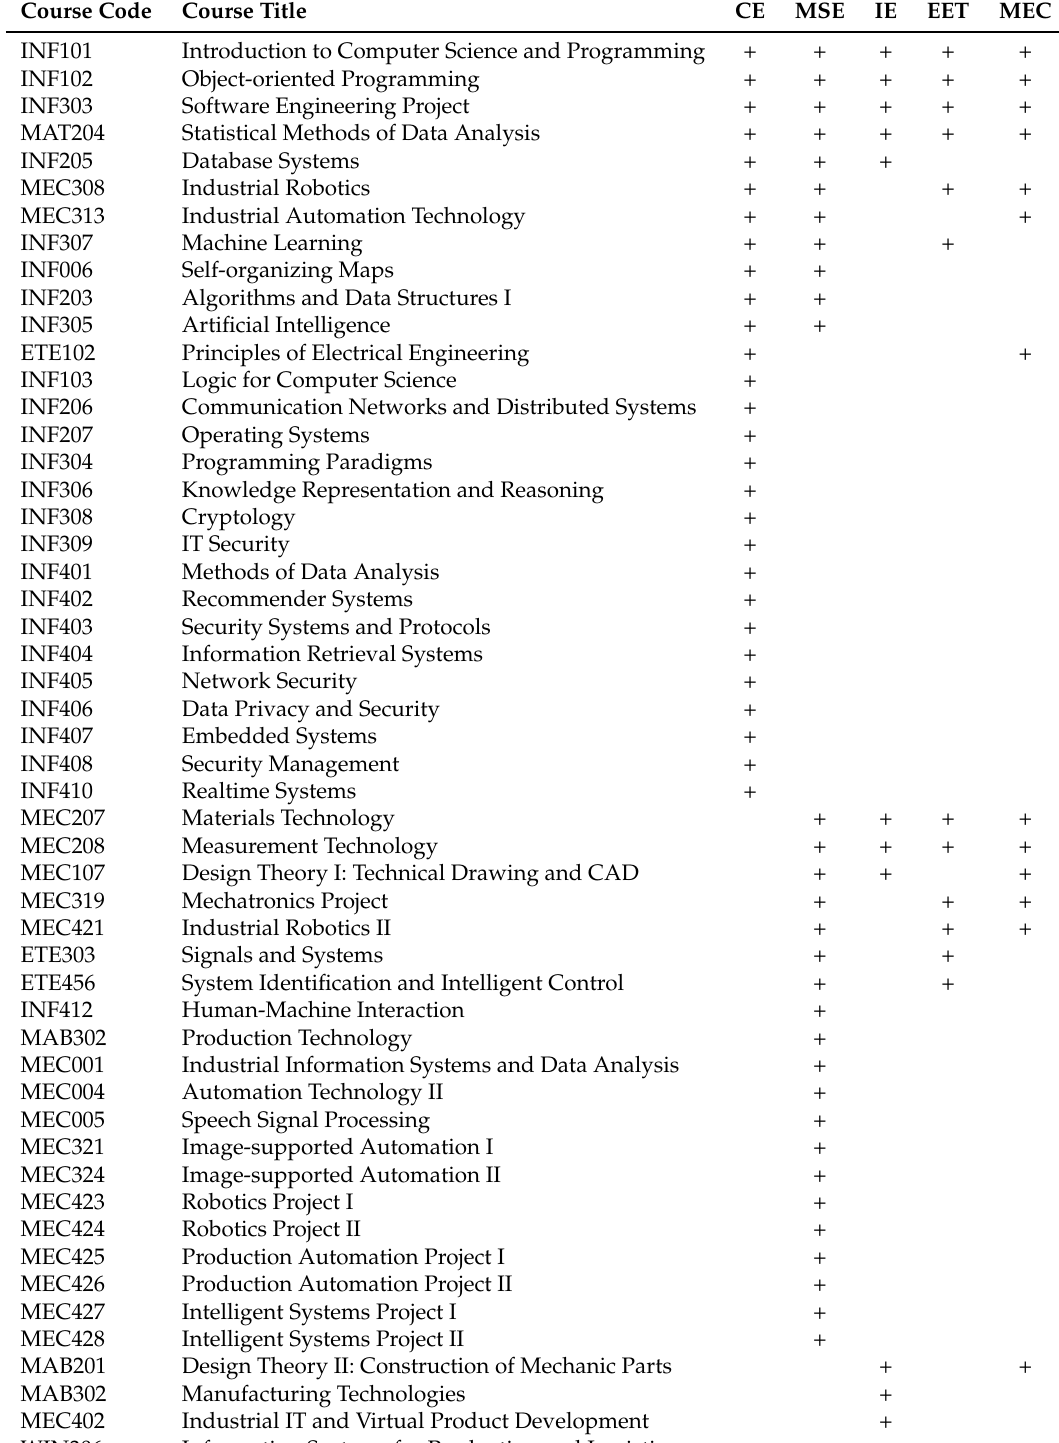
Table 1. Industry 4.0-related courses at the Turkish German